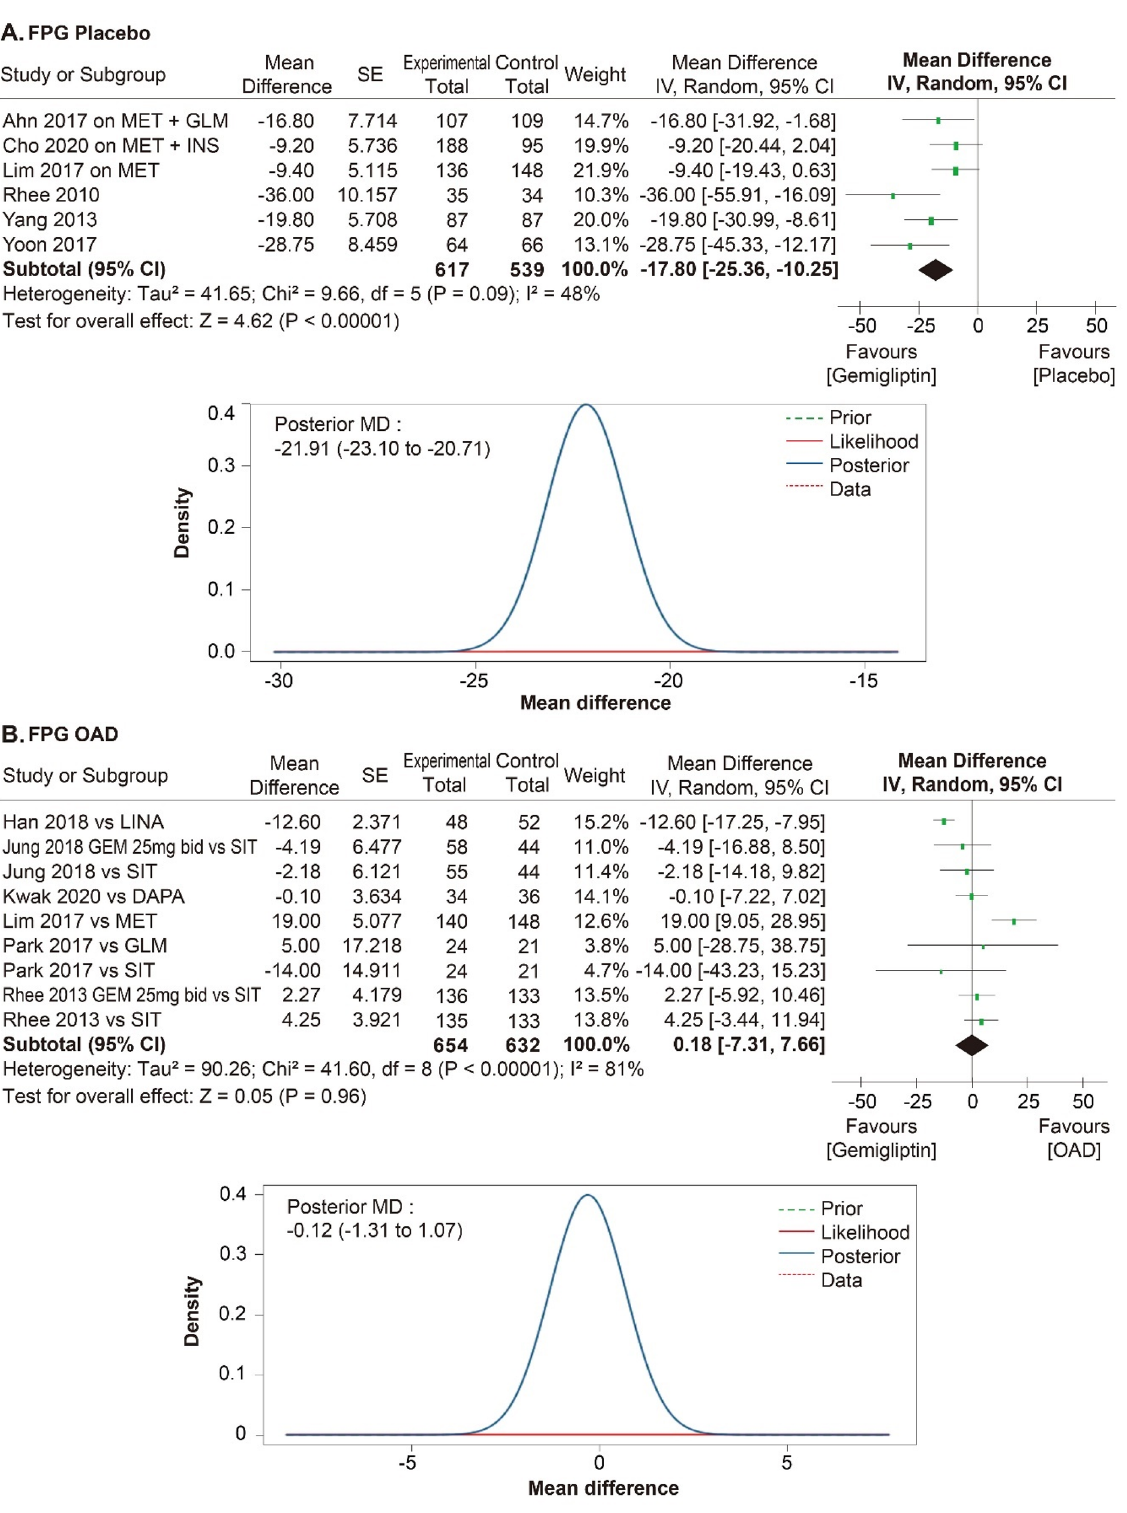
Figure 5. Forrest plot of RCTs for the effect of gemigliptin on